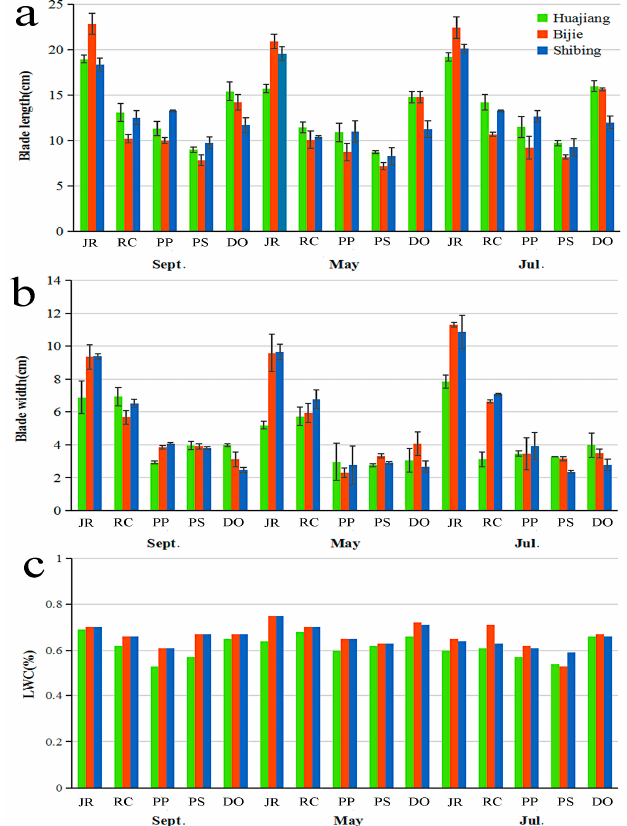
Figure 3. Leaf characteristics of host plants in the three different study areas (( a ): blade length; ( b ): blade width; ( c ): leaf water content). ( b ): blade width; ( c ): leaf water